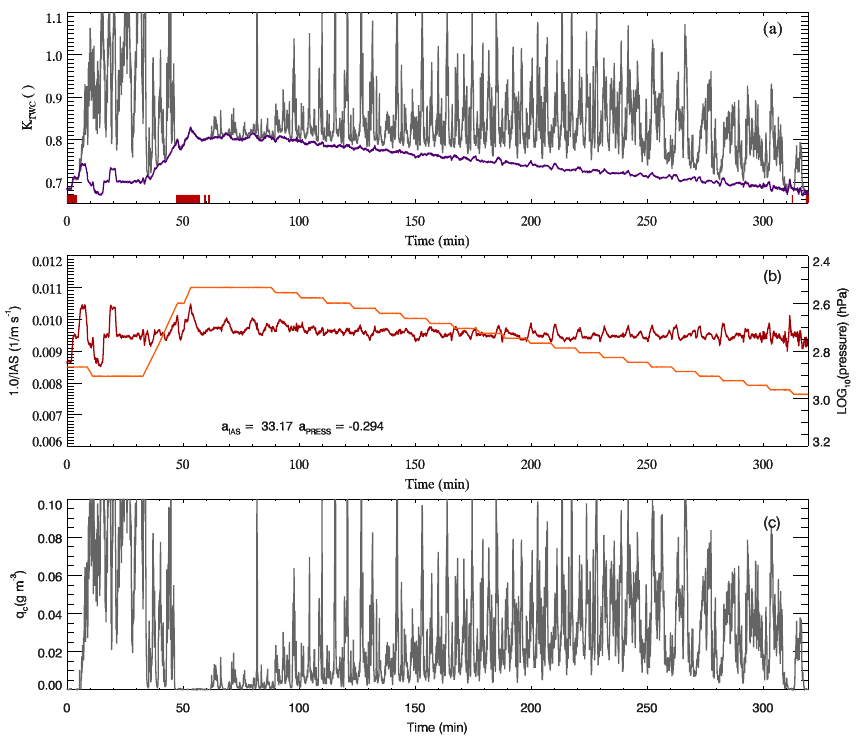
Figure A2. Data from flight B672 which was mostly in cloud. In panel (a) the grey line is the measured ratio of collector to reference power, and the purple line is the parametrised K . The red bars represent the times when in cloud-free air. Panel (b) shows the variation of 1 /V IAS (the red line) and LOG 10 (P) (the orange line) during the flight. Panel (c) shows the baseline-corrected q c using the best-fit parametrised K